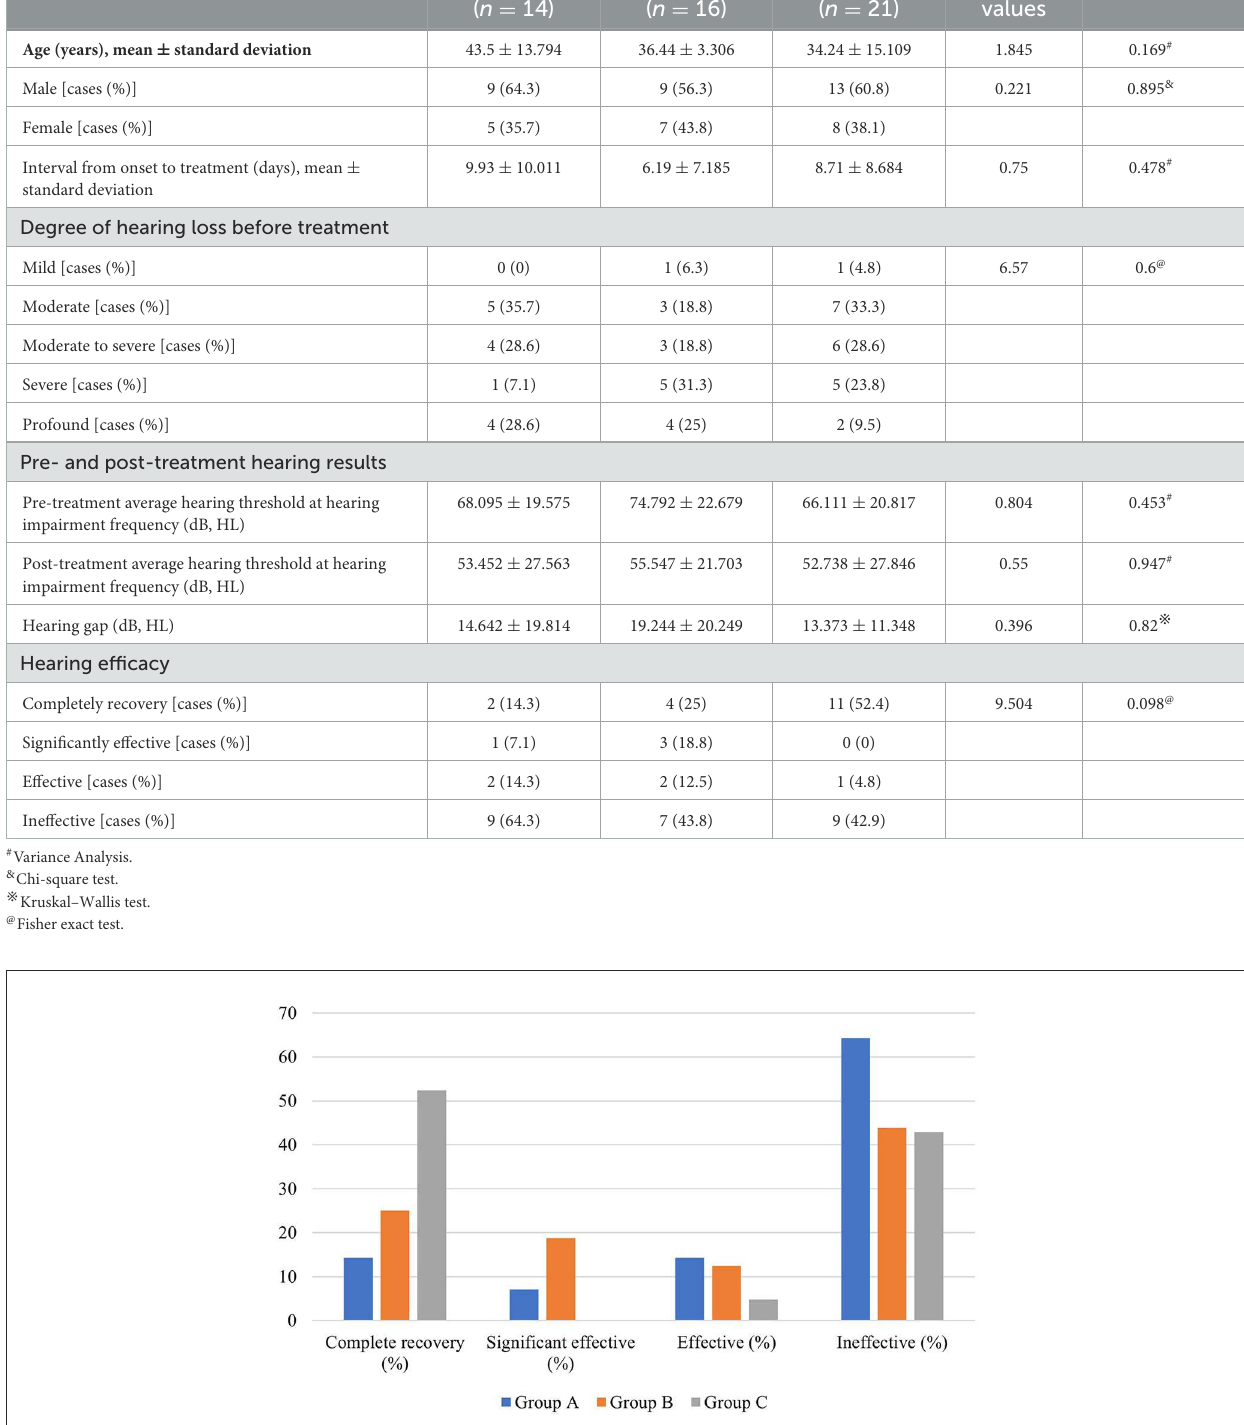
P -values Group B Group C Statistical ( n = 14) ( n = 16) ( n = 21) values